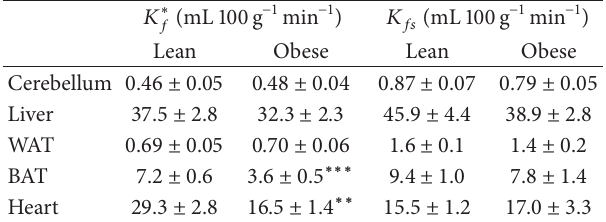
Table 2: 3 H-R-BrP clearance ( 𝐾 ∗ 𝑓 ) and 14 C-P clearance into storage products ( 𝐾 𝑓𝑠 ) in individual tissues of lean and obese Zucker rats in vivo .